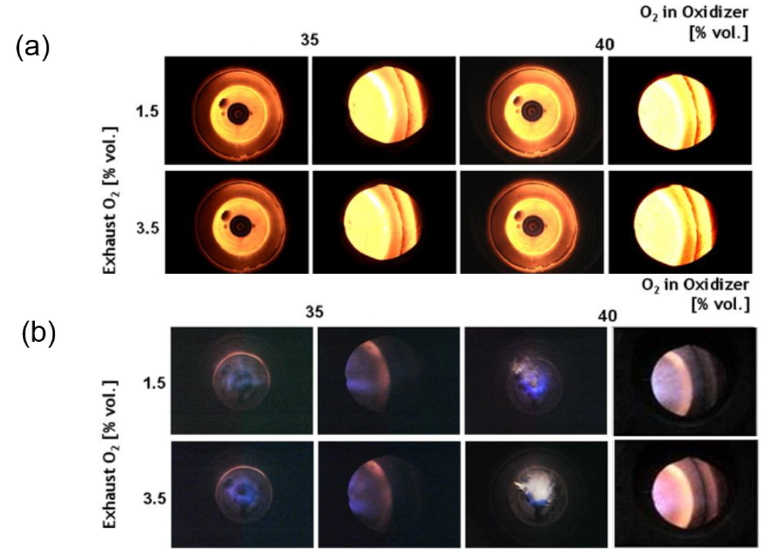
Figure 6. Flame images (front and side) for different recirculation rates in oxy-fuel FGR combustion: ( a ) 100% and ( b ) 50% loads.